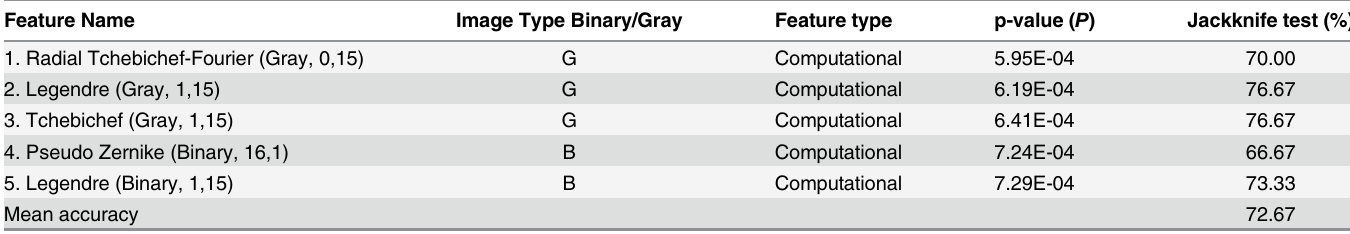
Table 3. The top – 5 features with the smallest P values for neurons.